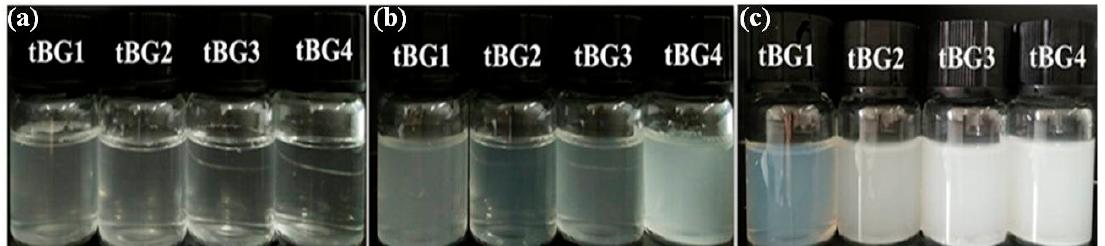
Figure 3. Photographs of the triblock-graft copolymers solutions (2.00 mg/mL) at 25 °C ( a ), 35 °C ( b ), and 45 °C ( c ).